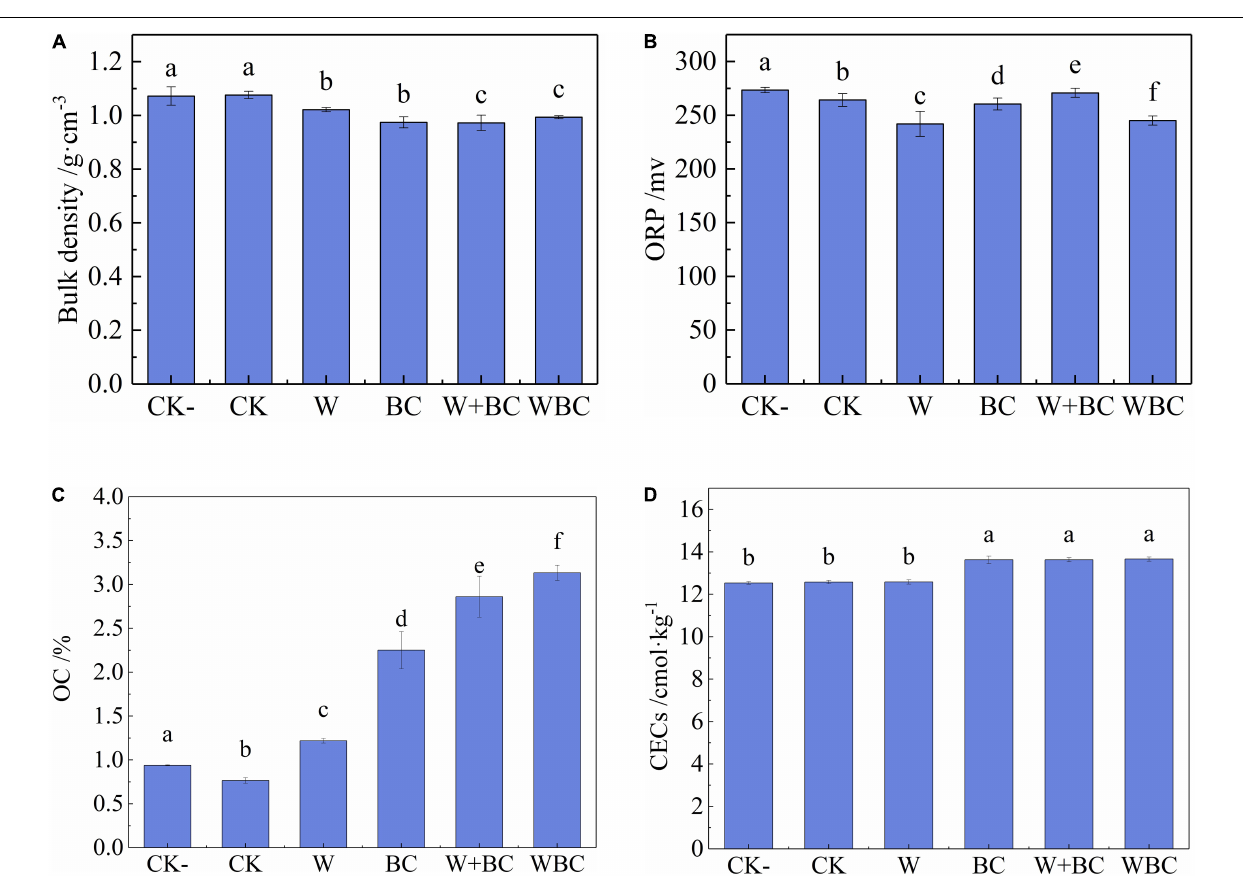
FIGURE 3 | Soil characteristics with different remediation methods. (A) Bulk density. (B) Redox potential. (C) Organic carbon. (D) Cation exchange capacity. Error bars represent the standard deviation of the mean ( n = 3). Values in a given column followed by the same letter are not significantly different ( P < 0.05) using Tukey